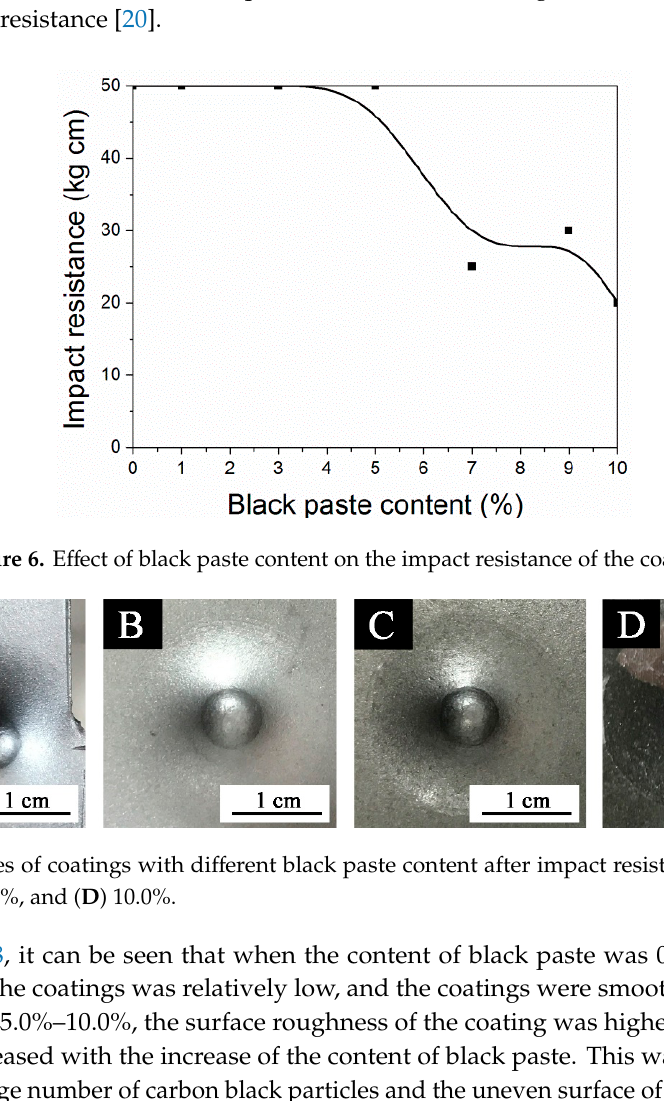
Figure 5. Images of coatings with different black paste content after adhesion test: ( A ) 0, ( B ) 1.0%, ( C ) 7.0%, and ( D ) 10.0%.